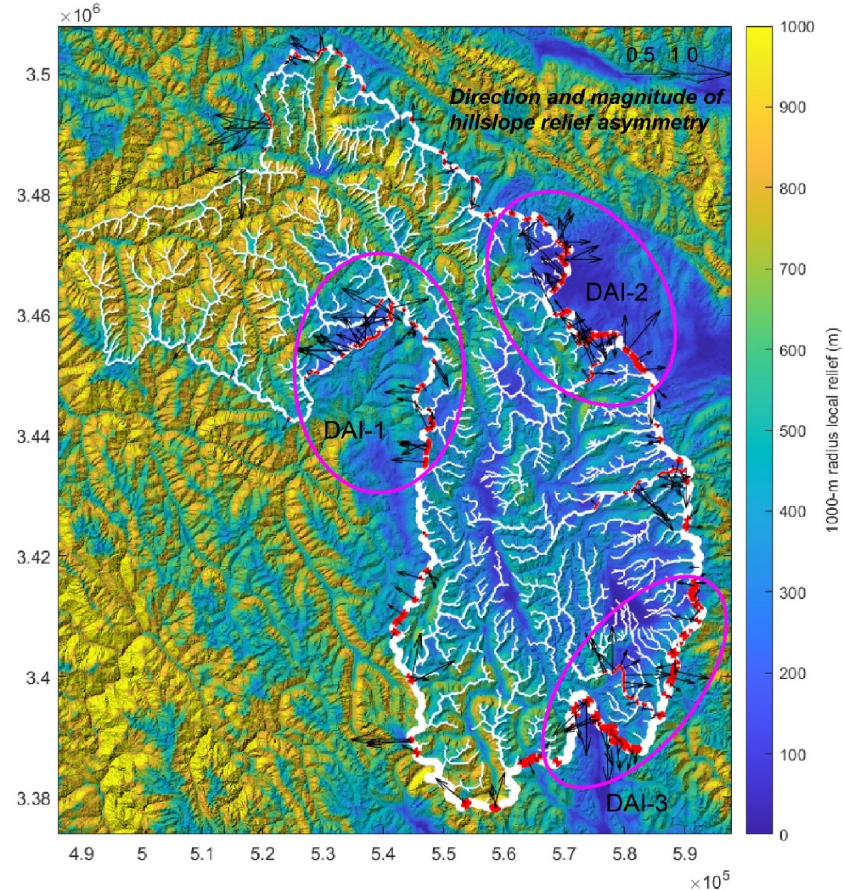
Figure 8. Anomalous divides in the Zengqu River catchment. White lines show the divide network, and red lines depict asymmetric (DAI > 0.4) divide edges. Black arrows indicate the direction and magnitude of the DAI, with the arrow pointing in the direction of the inferred direction of divide migration. The ellipses with the magenta line is significant anomalous divides.